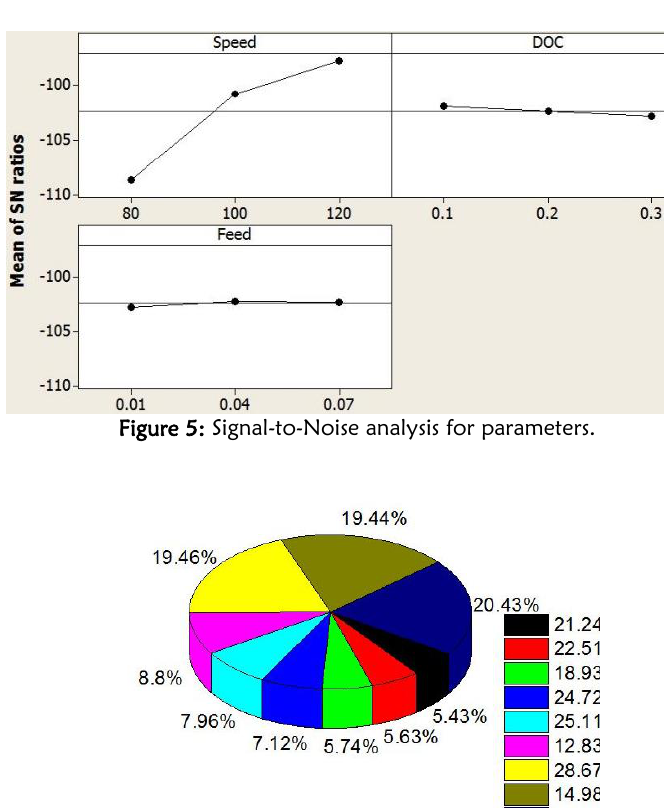
Figure 4: Energy consumed during Runs